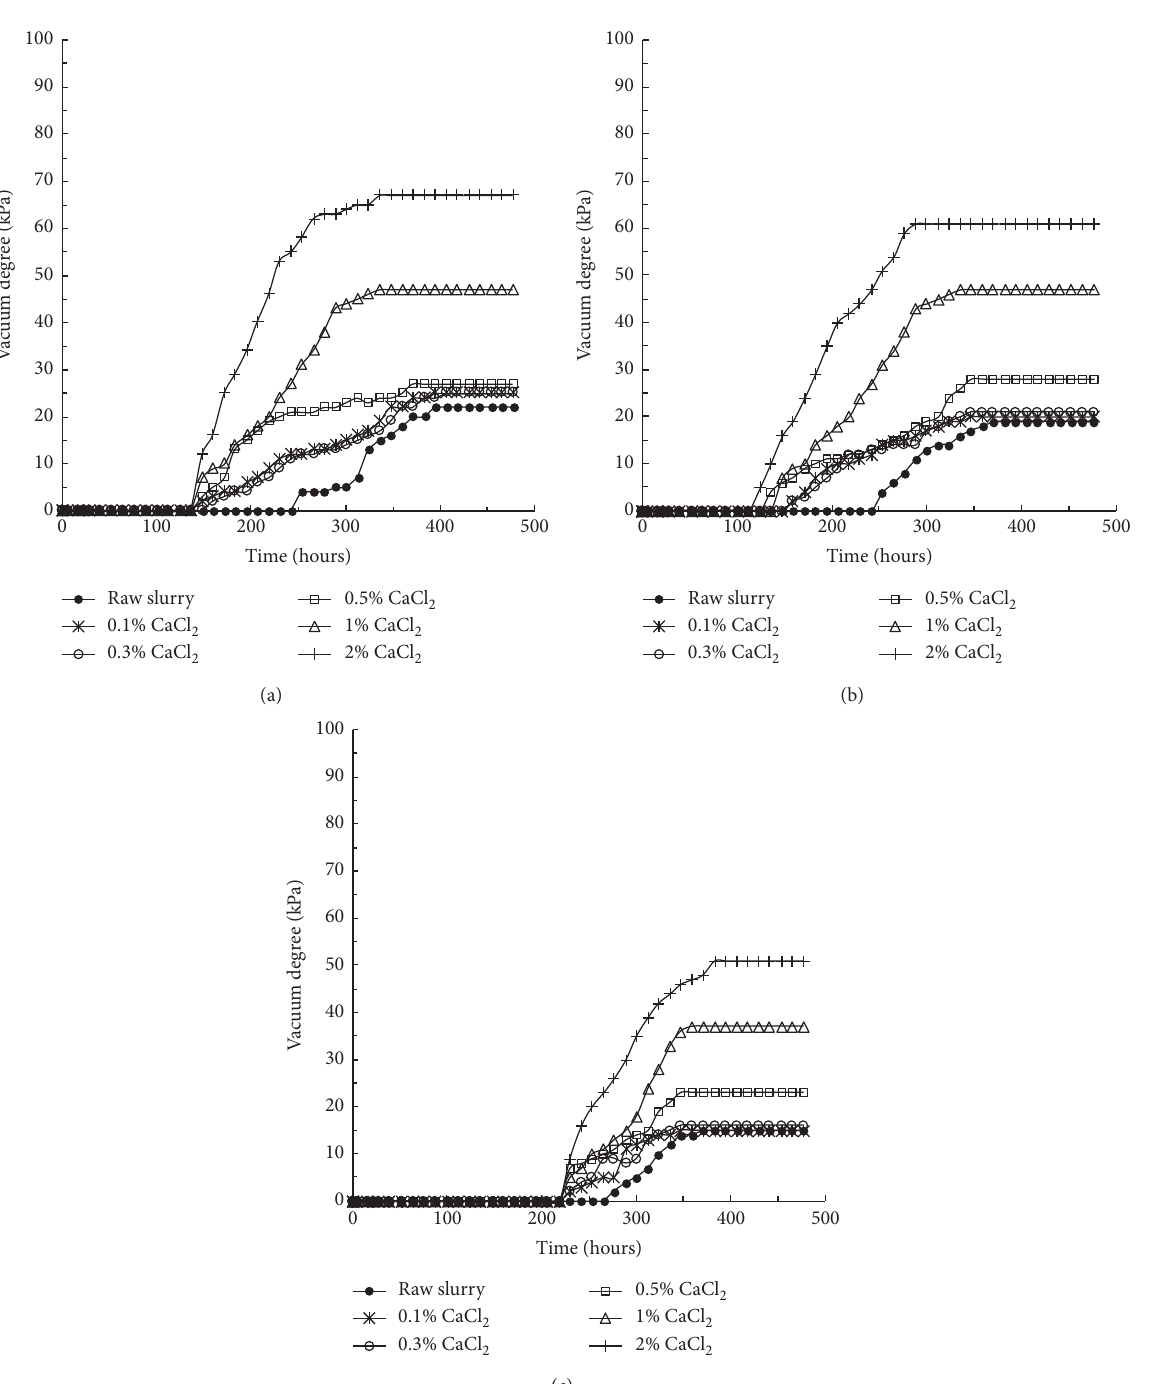
Figure 5: Variation of vacuum degree with distance to PVD for slurry with CaCl